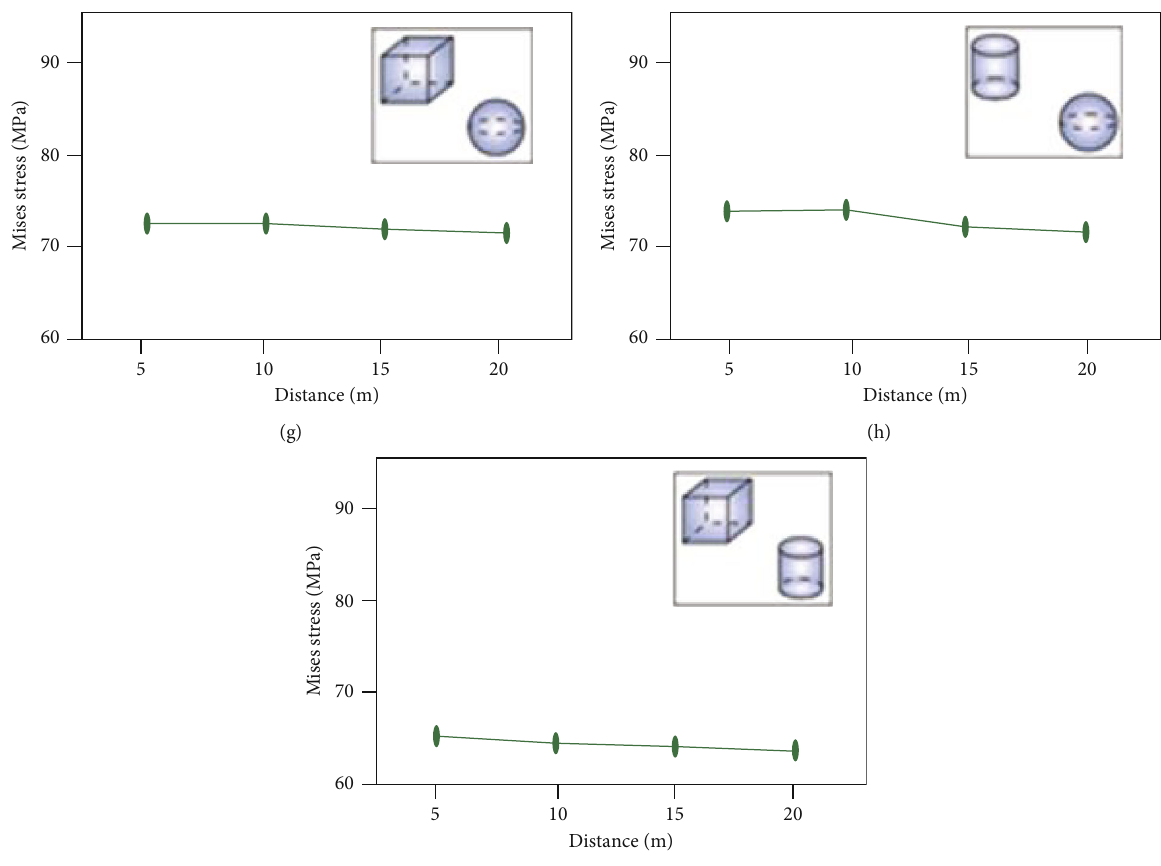
Figure 7: Mises stress variation diagram for the combination patterns of double